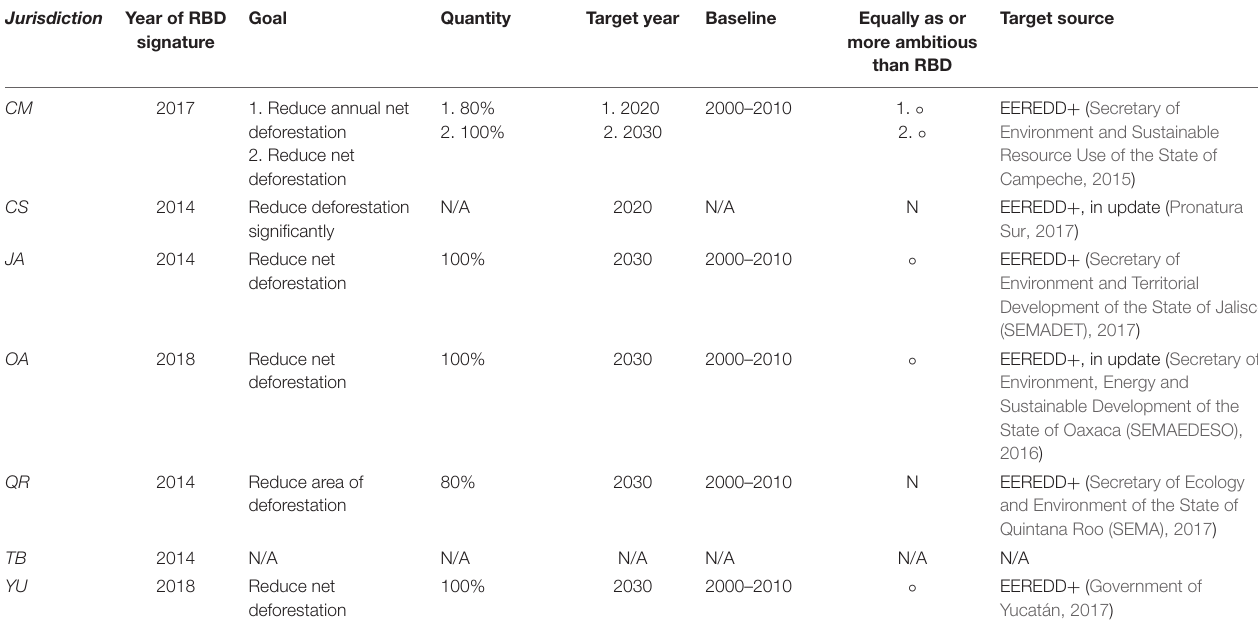
TABLE 4 | Inventory of deforestation targets (“legal targets”) of the seven GCF TF member jurisdictions located in